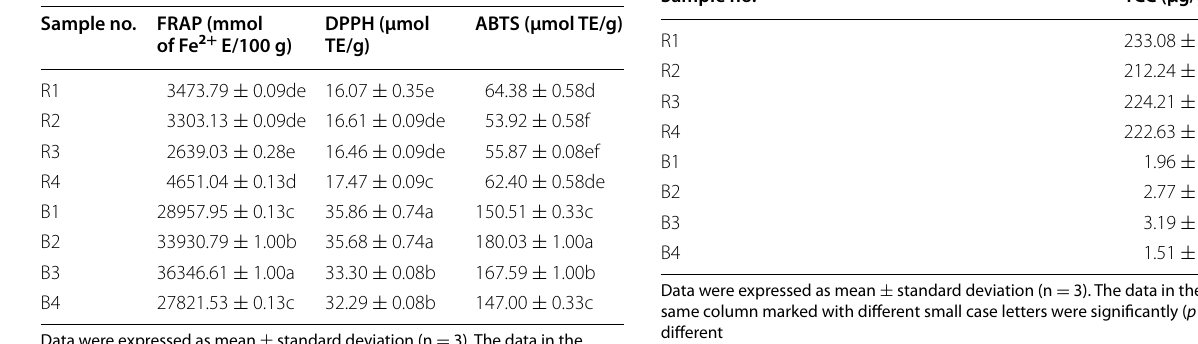
Table 3 Antioxidant capacities (DPPH, FRAP, ABTS) of goji berry